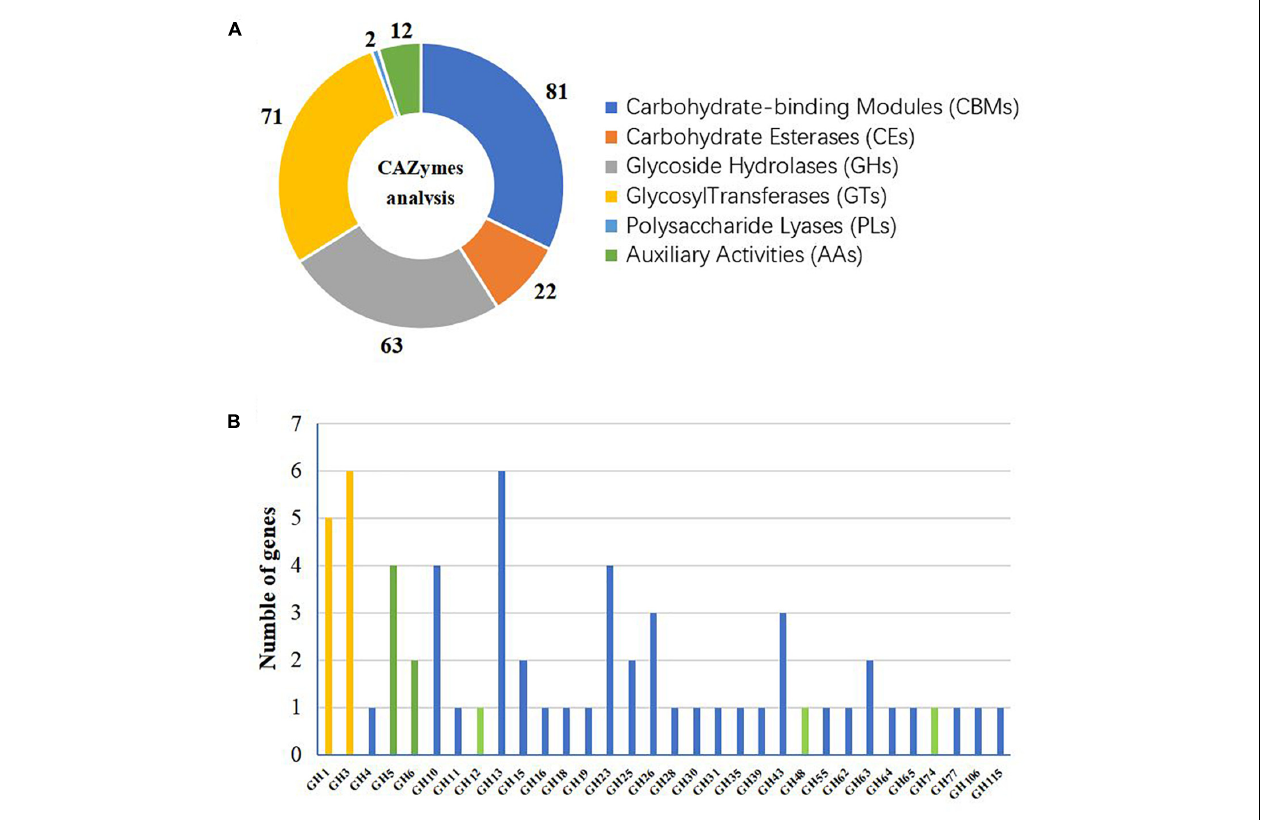
FIGURE 1 | Glycoside hydrolase (GH) families of Actinomadura amylolytica YIM 77502 T . (A) CAZyme analysis. (B) Number of GH genes. Histogram colors indicate different functions: yellow indicates predicted β -glucosidase, green indicates predicted cellulase, and blue indicates other predicted